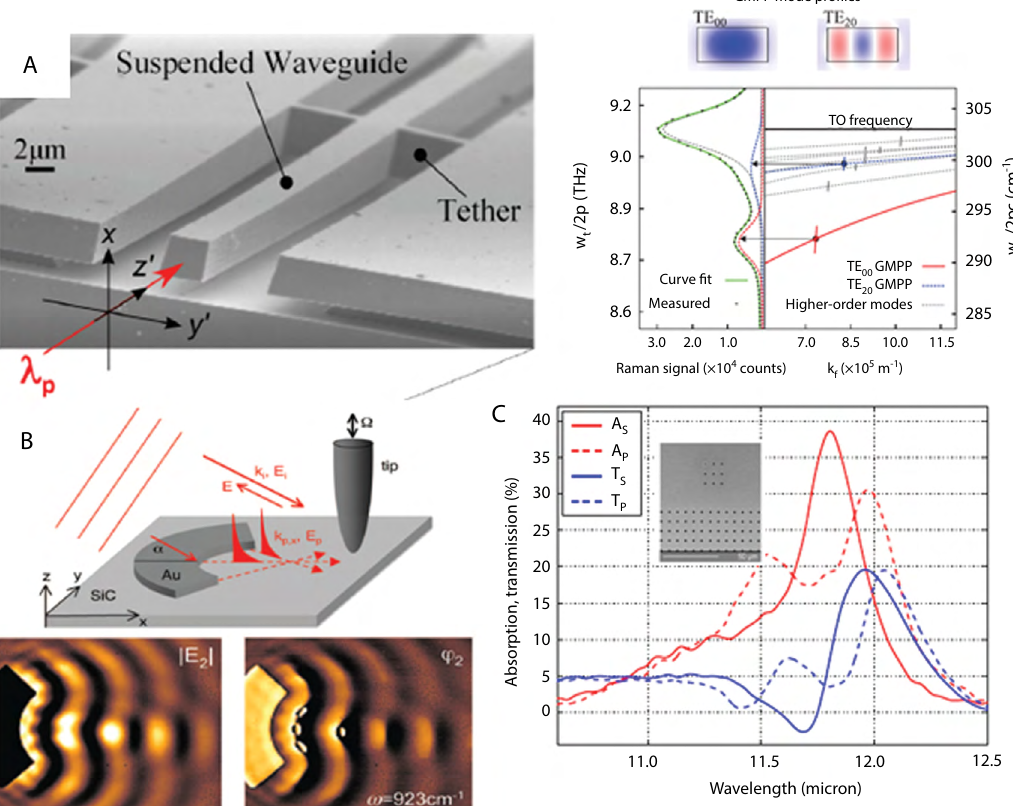
(red solid curve), 00 | 2